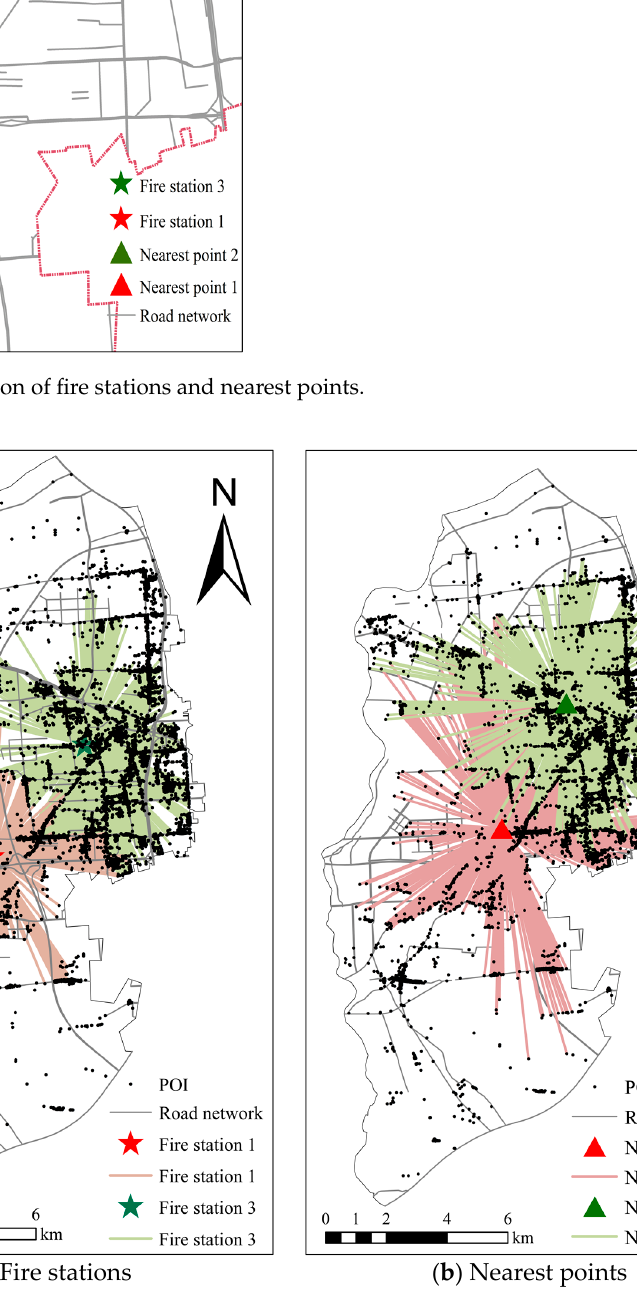
Figure 6. Coverage of